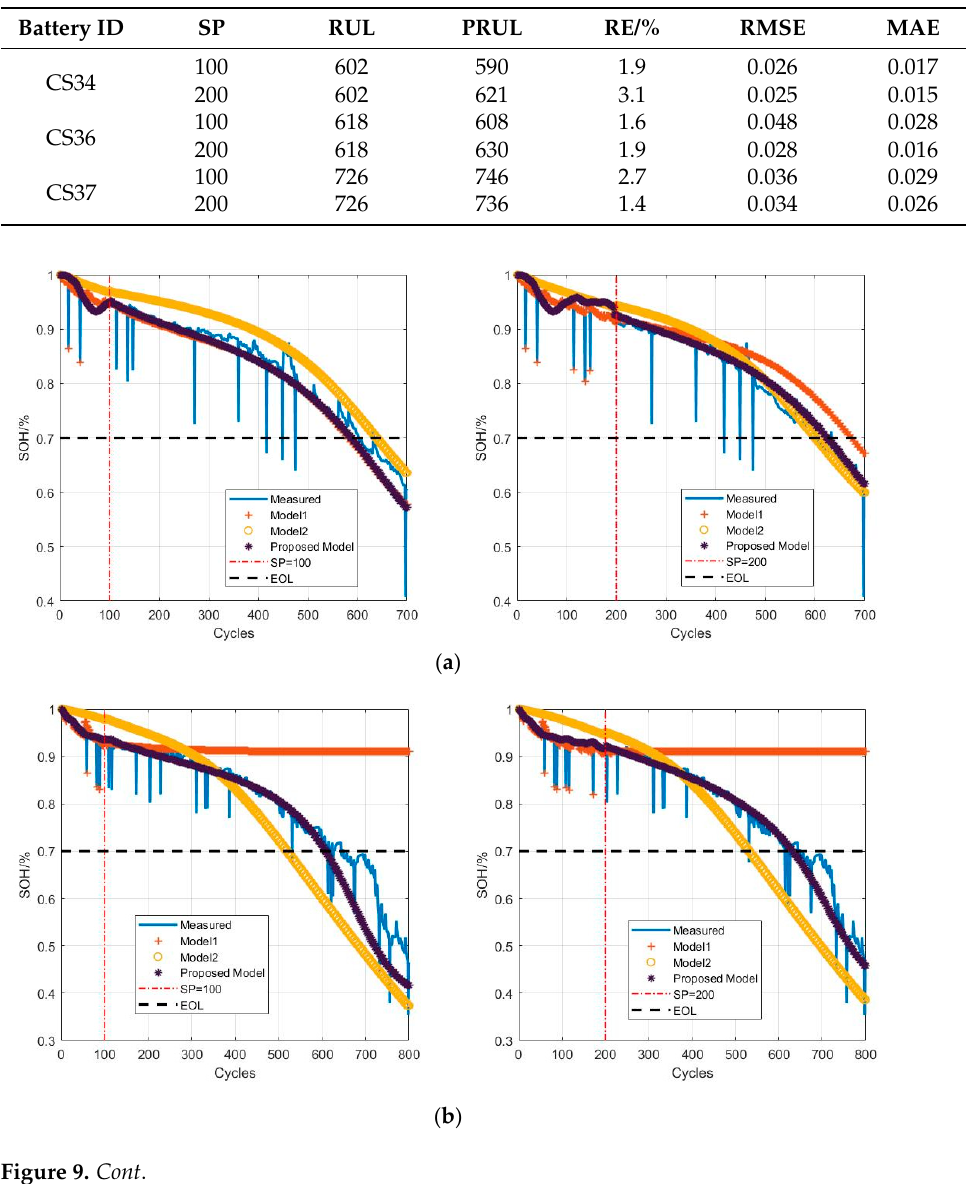
( c ) Figure 9. RUL prediction results of the proposed method for CALCE batteries under different start- ing points: ( a ) CS34; ( b ) CS36; ( c ) CS37. Table 1. Performance on the CALCE dataset. Battery ID